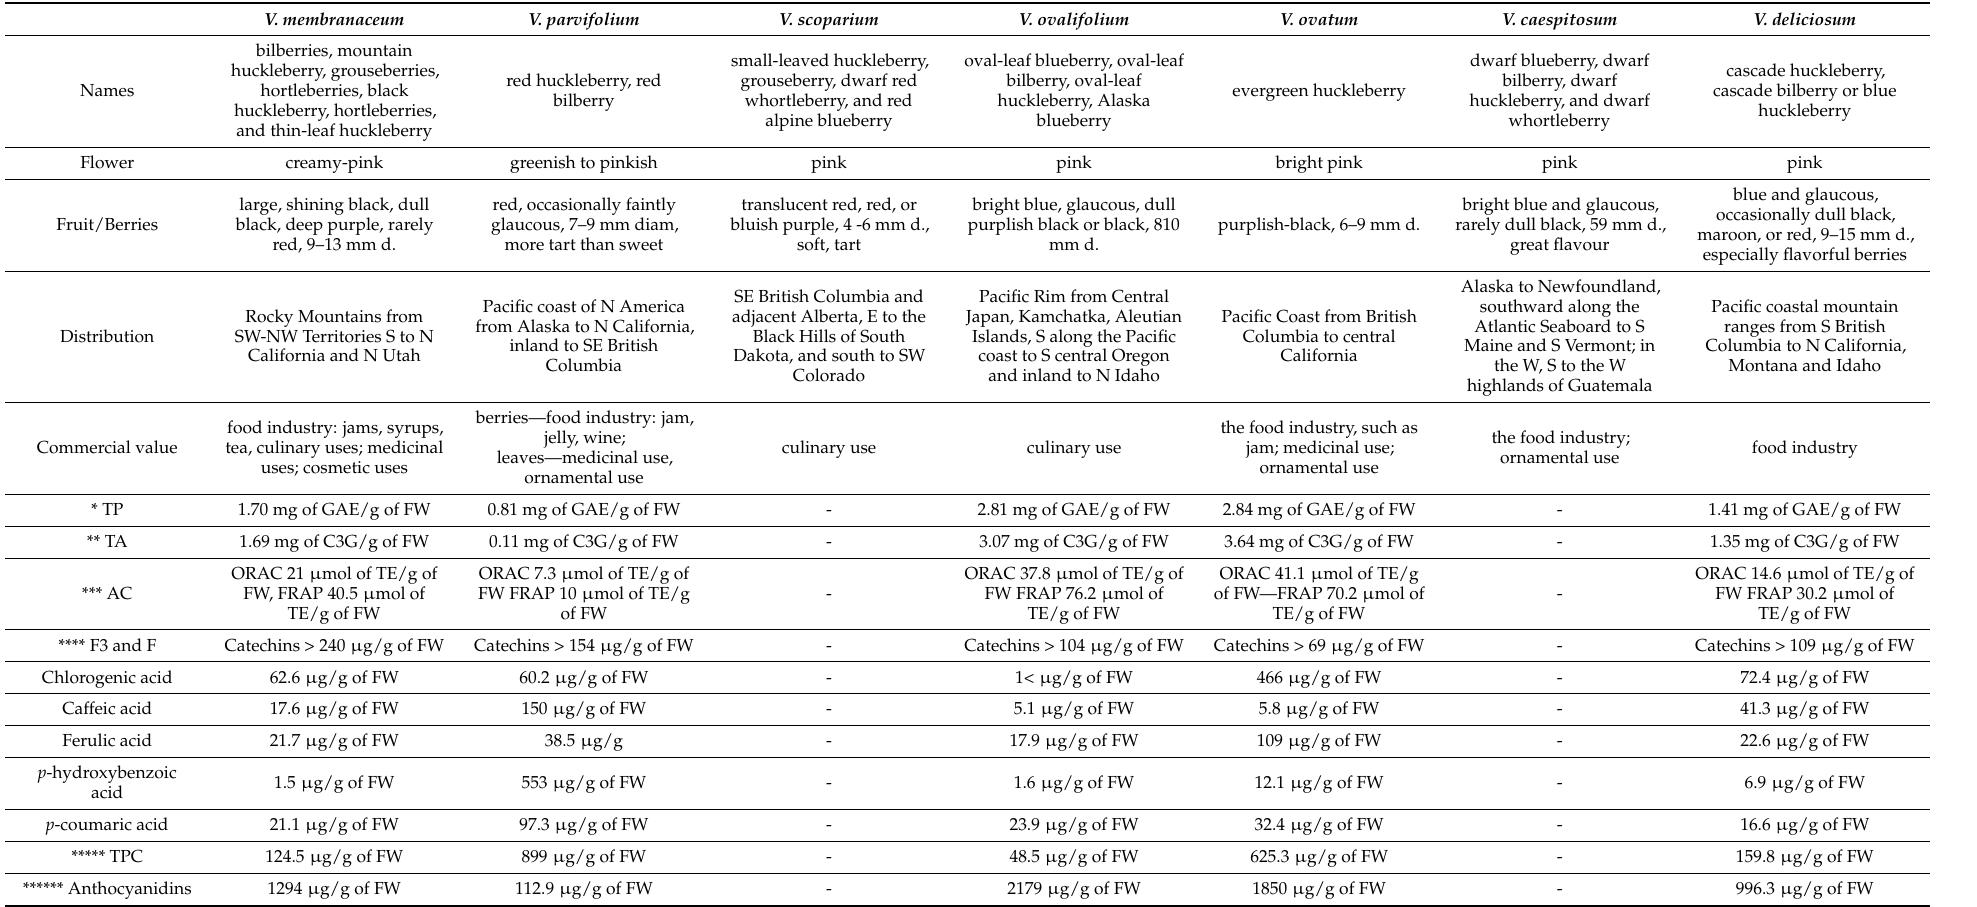
Table 6. Huckleberry species and characteristics, adapted from